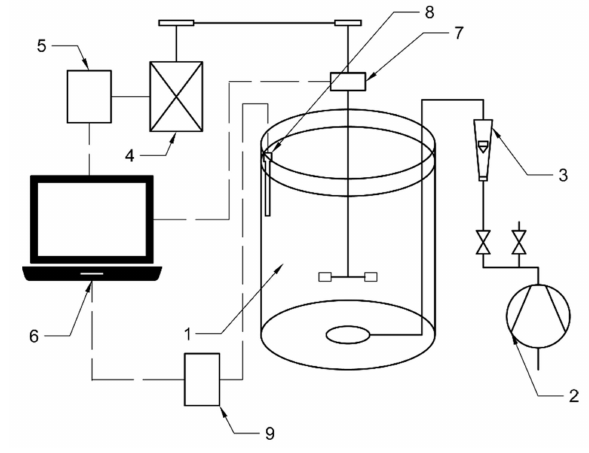
Figure 1. Experimental set-up. The motor was controlled by inverter (5) Schneider Electric p-Drive MX-Eco and generates reverence curves for unsteady mixing. The vessel was equipped with a radial impeller with a diameter of D = 0.1 m. Four types of impellers were used: Rushton turbine, BT-6, BT-4, and BT-33 (Figure 2). A Rushton turbine was used as a reference impeller and BT-6, BT-4, and BT-33 to investigate the effect of blade shape and blade orientation on gas hold-up and volumetric mass transfer coefficient k L a. Impeller bottom clearance C was equal to impeller diameter C = D. The time course of impeller speed was based on a triangular waveform described elsewhere [8].